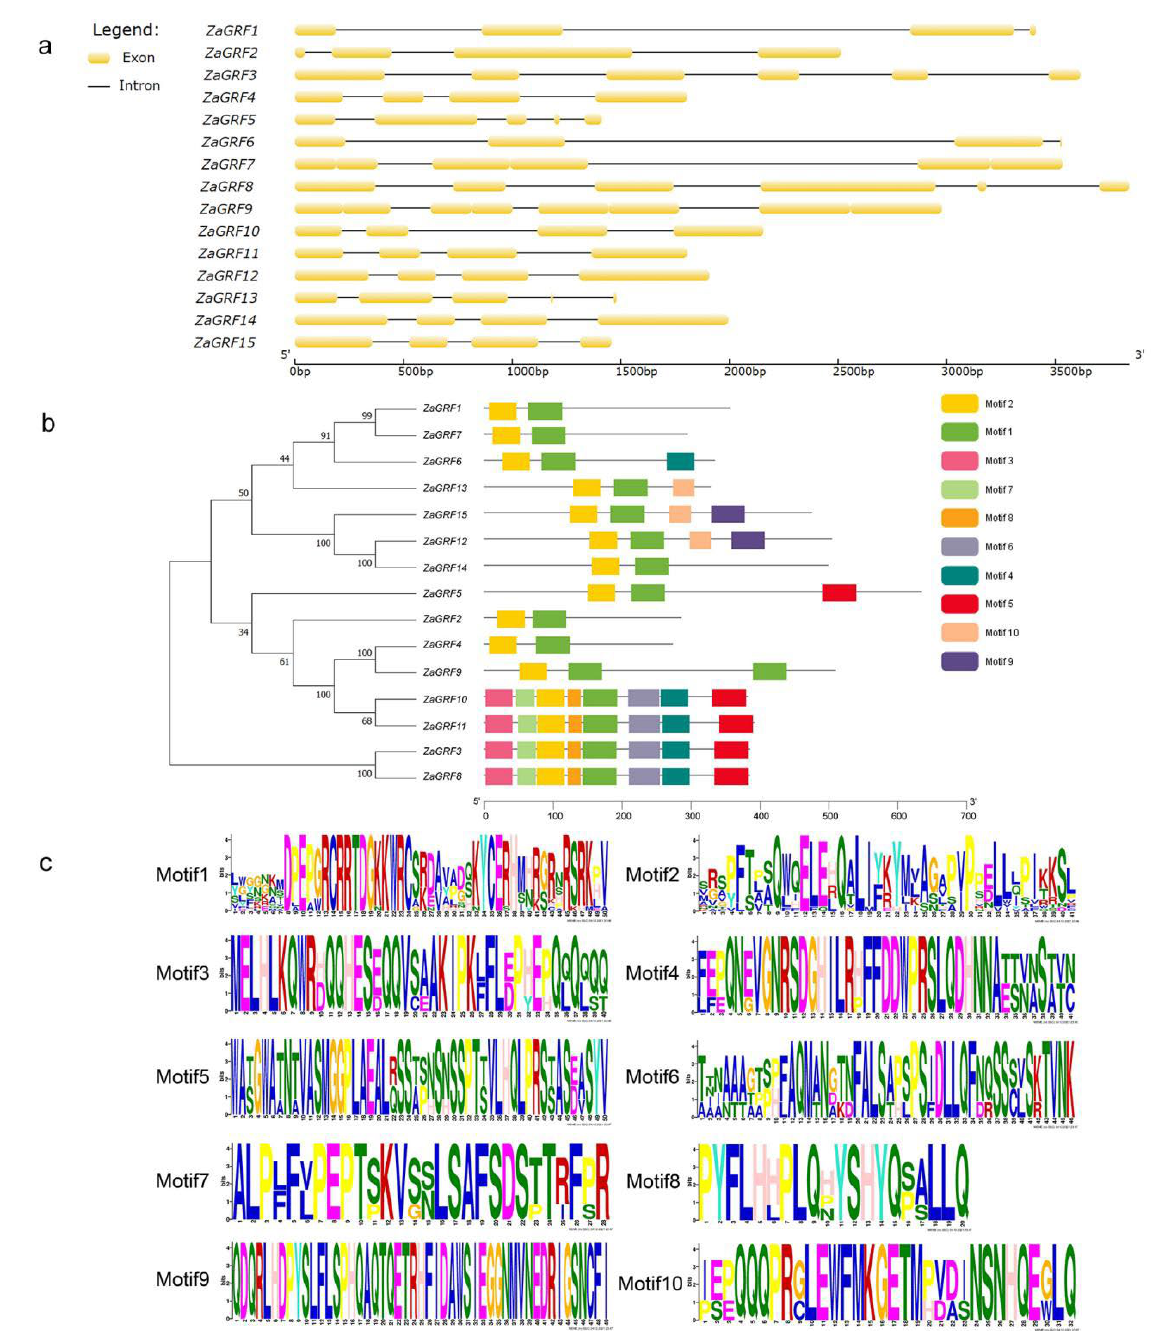
Figure 5. Gene structures (a) , phylogenetic tree and motif distribution (b) and logo map of motifs (c) of ZaGRFs . ( c ) of ZaGRFs